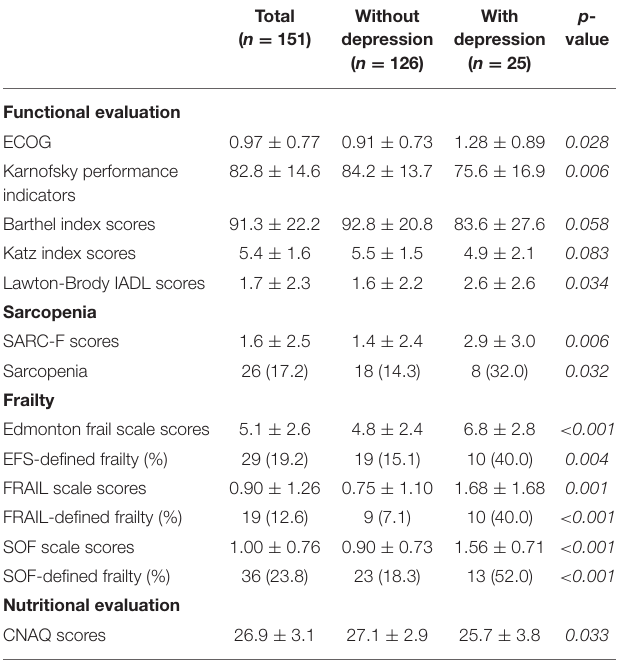
TABLE 2 | Functional and geriatric syndrome evaluation results of study participants.